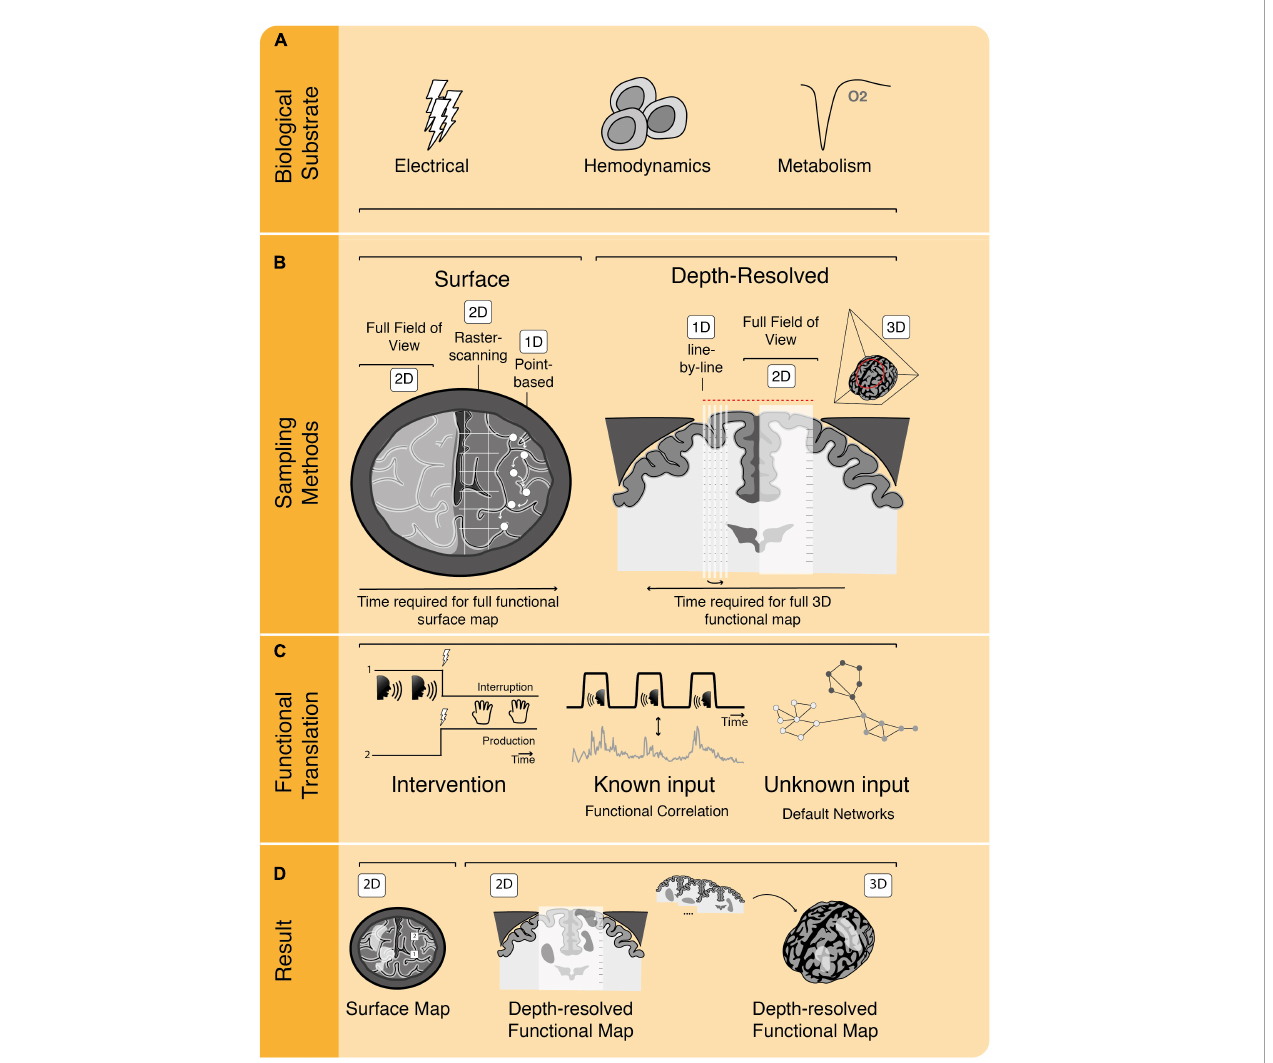
FIGURE2 The process of functional image acquisition. (A) Functional imaging techniques rely on detection of one or more underlying biological substrates which serve as indicators of functional activity. (B) Roughly, techniques can be subdivided in surface and depth-resolved, penetrative techniques, which either build their full field of view at once (in 2D or 3D) or using subsamples, such as point-based, raster-based or line-by-line scanning. (C) To translate from acquired data to functional information, techniques rely on one or more of three methods. They can be intervention-based, probing the brain by interrupting or producing certain behavior. They can rely on known input patterns of pre-defined functional tasks to use for functional correlation or they can use functional connectivity analyses without known inputs (i.e., determining resting-state or default networks). (D) Once functional analyses have been performed, functional maps are displayed as, e.g., 2D surface maps or 2D/3D depth-resolved functional